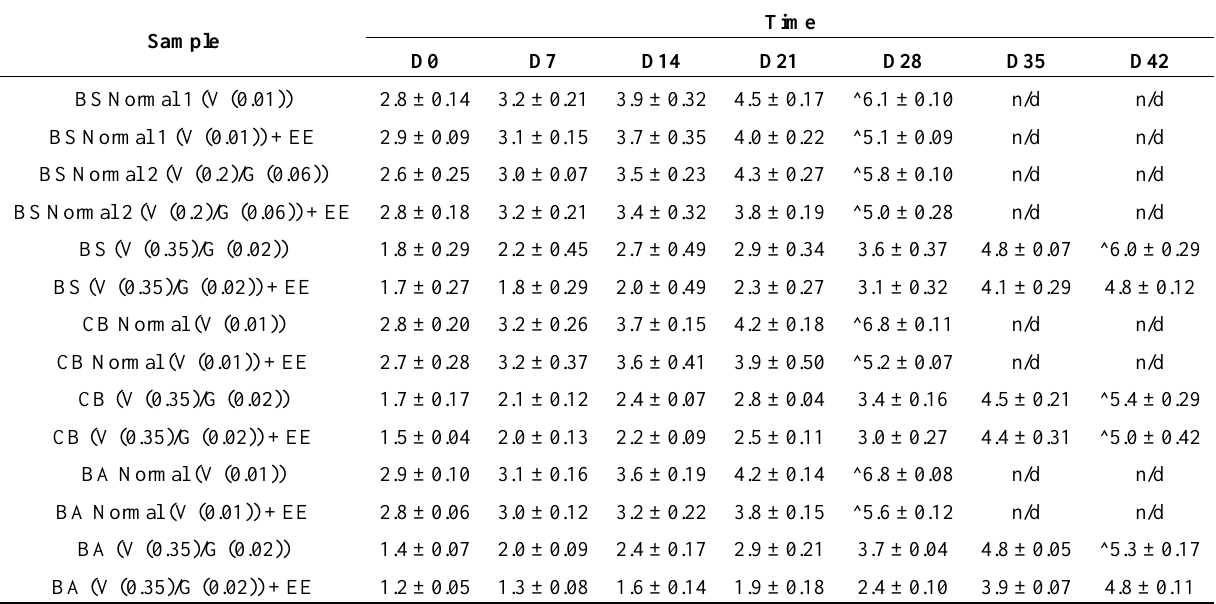
Table 6. Mean log10 mould counts for varying treatments (MPa) across three products, n/d—not determined due to ^ exceeding limits (10 5 /g or 5 log10 (cfu/g) [31]) or presence of visual